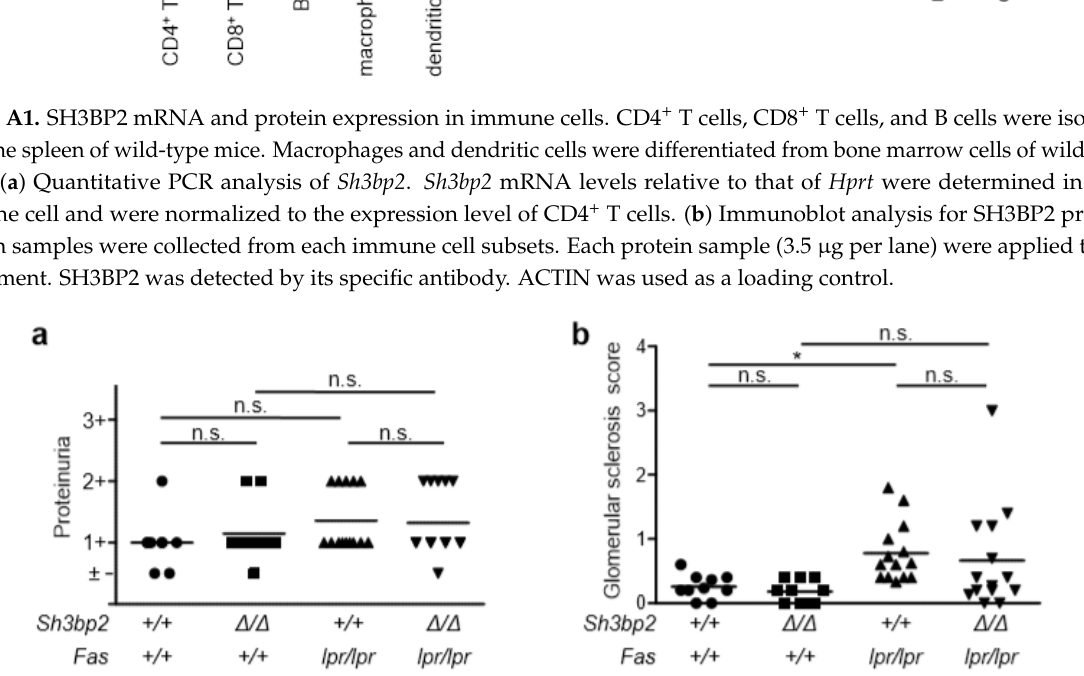
Figure A2. Urinary protein and histologic changes in the SH3BP2-deficient lupus mice. Sh3bp2 +/+ ( n = 10), Sh3bp2 Δ / Δ ( n = 10), Fas lpr/lpr ( n = 14), and Sh3bp2 Δ / Δ Fas lpr/lpr mice ( n = 14) were analyzed at the age of 35 weeks. ( a ) Proteinuria of the spot urine samples was evaluated at the age of 35 weeks as follows: ±, <30 mg/dL; 1+, 30–99 mg/dL; 2+, 100–299 mg/dL, 3+, 300< mg/dL. ( b ) Glomerular sclerosis score. More than 5 glomeruli in each kidney section were assessed and the averages were calculated. Each dot denotes an individual mouse, and horizontal lines represent the means. * p < 0.05; n.s.= not significant .